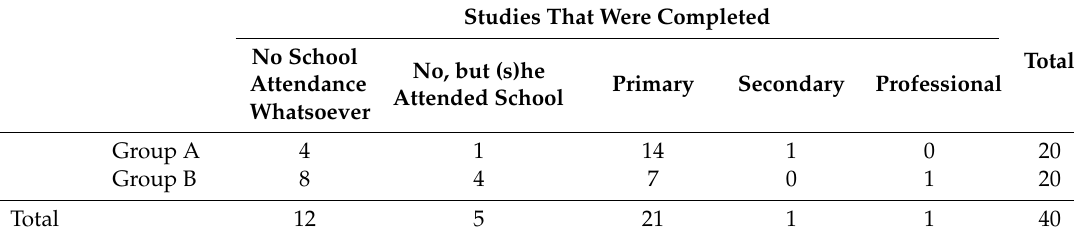
Table 4. Characteristics of the sample. Completed studies.